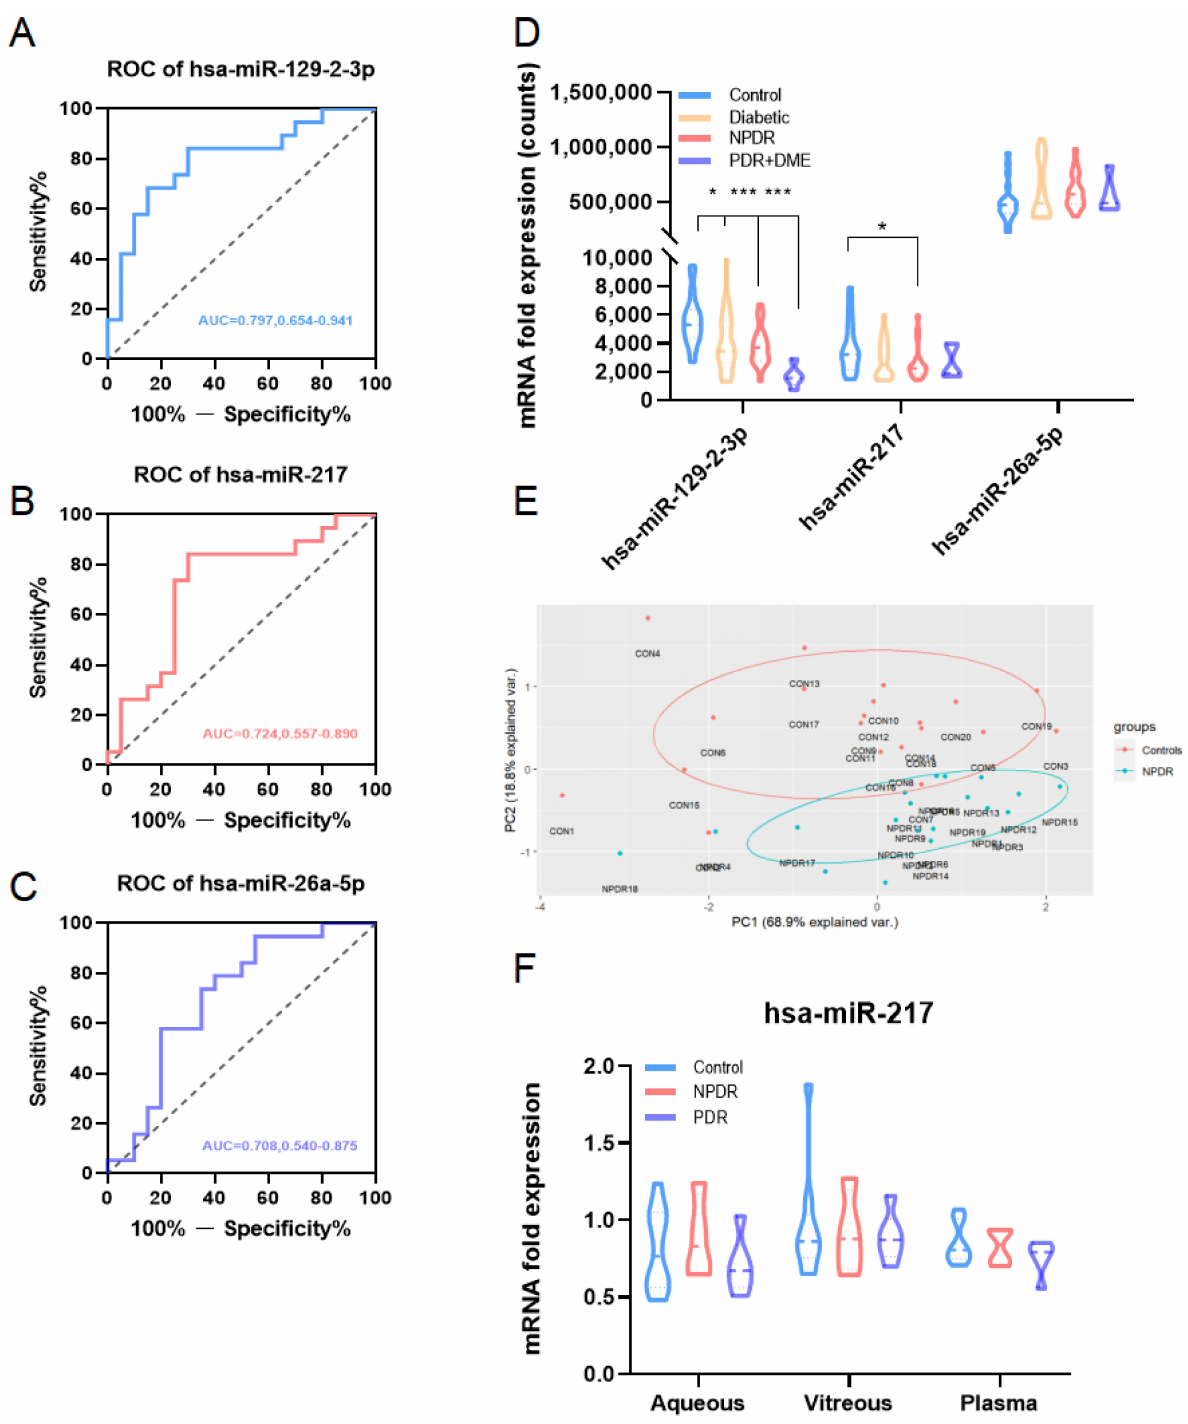
Figure 6. Validation of potential miRNAs by GSE160308. ( A – C ). ROC curves of three miRNAs with AUC > 0.7. ( D ). Expression level of miR-129-2-3p, miR-217 and miR-26a-5p in different groups of samples. Comparison of gene expression between two groups was performed by the Student’s t -test (mean ± SD, *** p < 0.001, p < 0.01, * p < 0.05). ( E ). PCA plot of healthy controls and NPDR patients by three miRNAs. ( F ). Expression level of miR-217 in different samples from DR